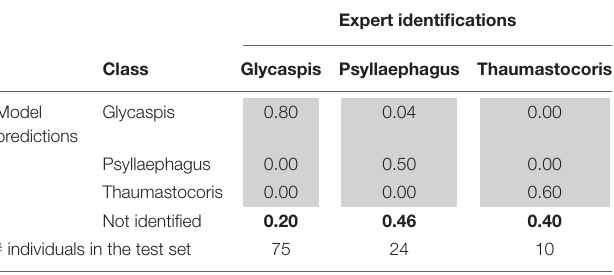
The model’s confidence threshold was set to 0.7. The gray-shaded area denotes the three focal insects, boldfaced proportions are false negative errors. The total number of individuals of each class, as determined by an expert, are presented in the bottom row.